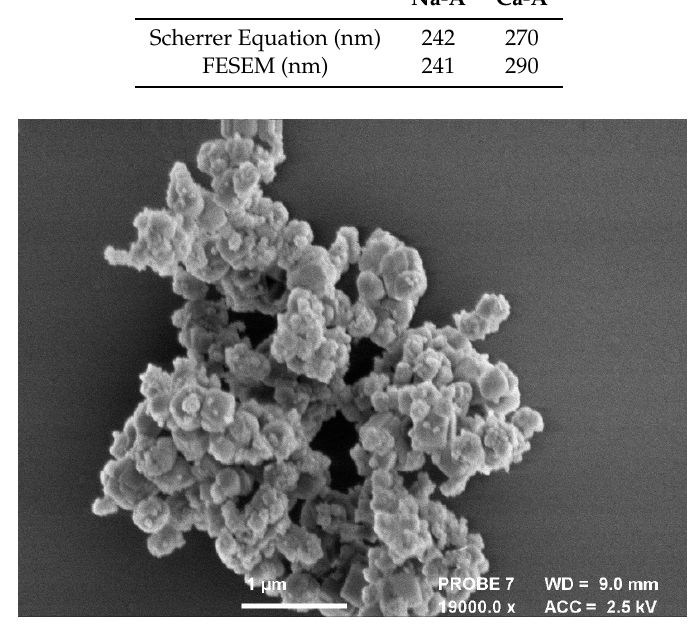
Figure 14. FESEM